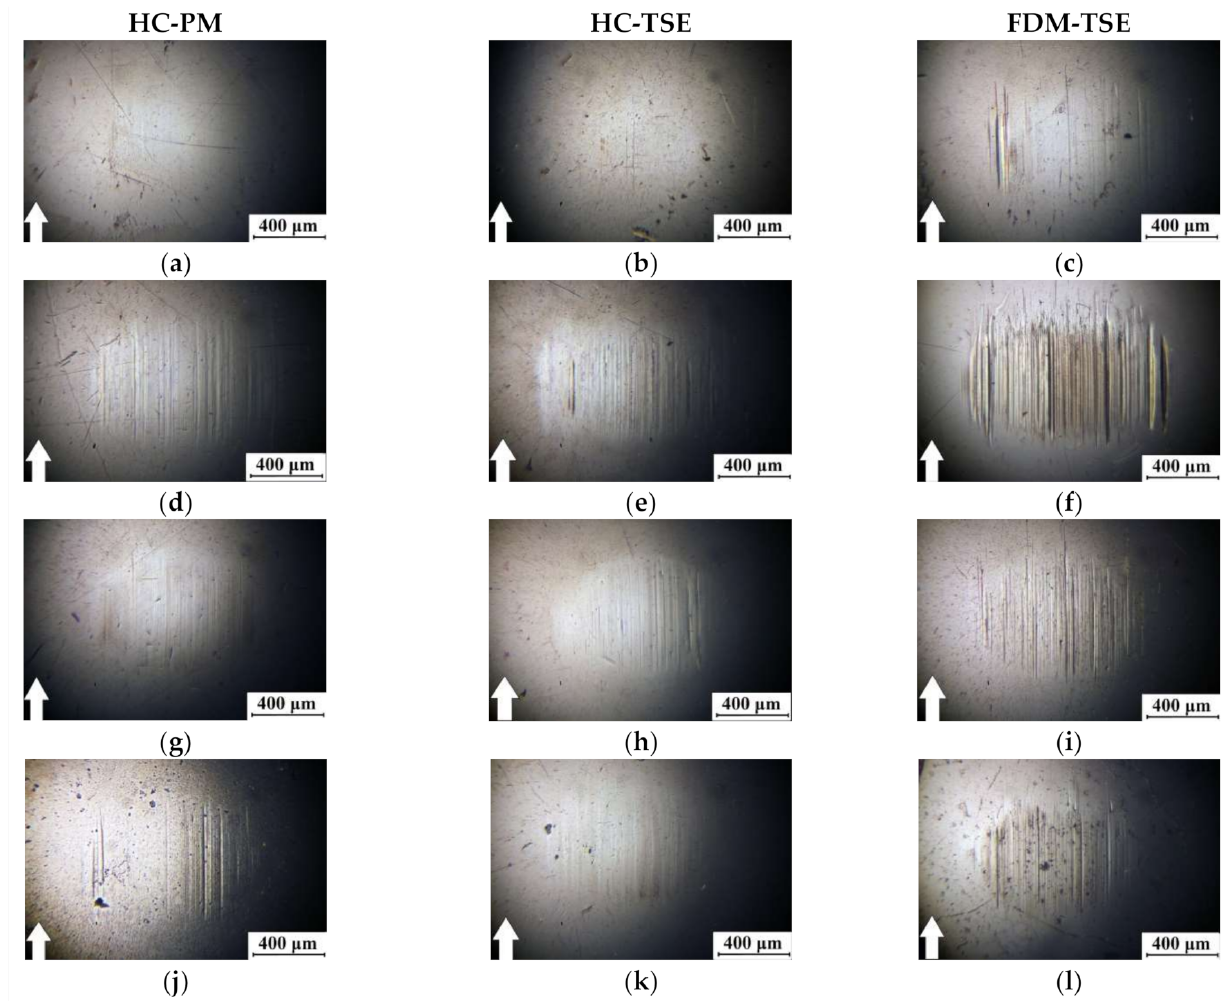
Figure 9. The wear track surfaces on the steel counterpart after the tribological tests on the ‘UHMWPE+17%HDPE- g-VTMS+12%PP’ sample ( a – c ) and the composites ( d – l ) fabricated by the HC-PM, HC-TSE, and FDM-TSE meth- ods: ‘UHMWPE+17%HDPE-g-VTMS+12%PP+5%HGS’ ( d – f ); ‘UHMWPE+17%HDPE-g-VTMS+12%PP+5%MGF’ ( g – i ); ‘UHMWPE+17%HDPE-g-VTMS+12%PP+5%CGF’ ( j – l ). The ‘pin-on-disk’